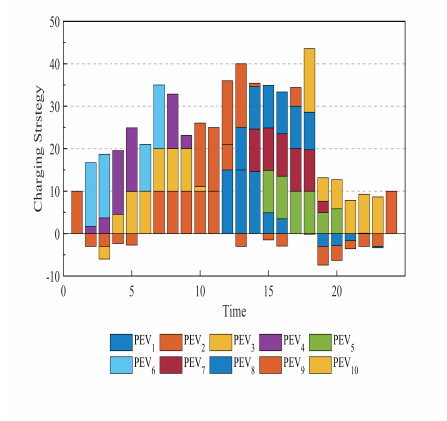
Figure 8. Charging capacity of 10 PEVs in a